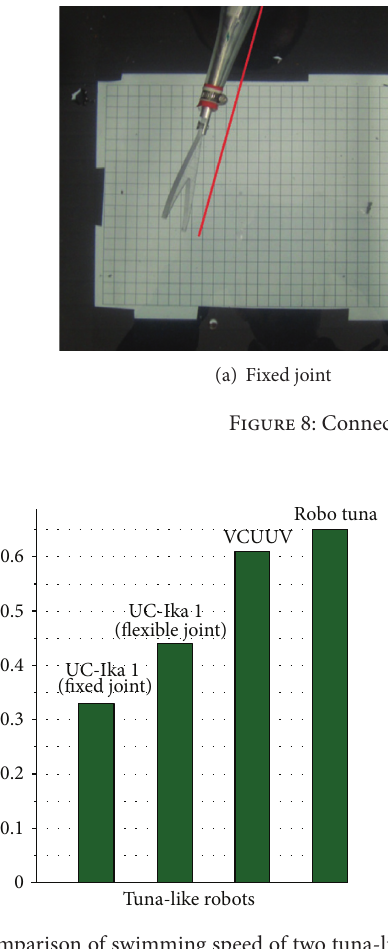
Figure 9: Comparison of swimming speed of two tuna-like robots with UC tuna-like